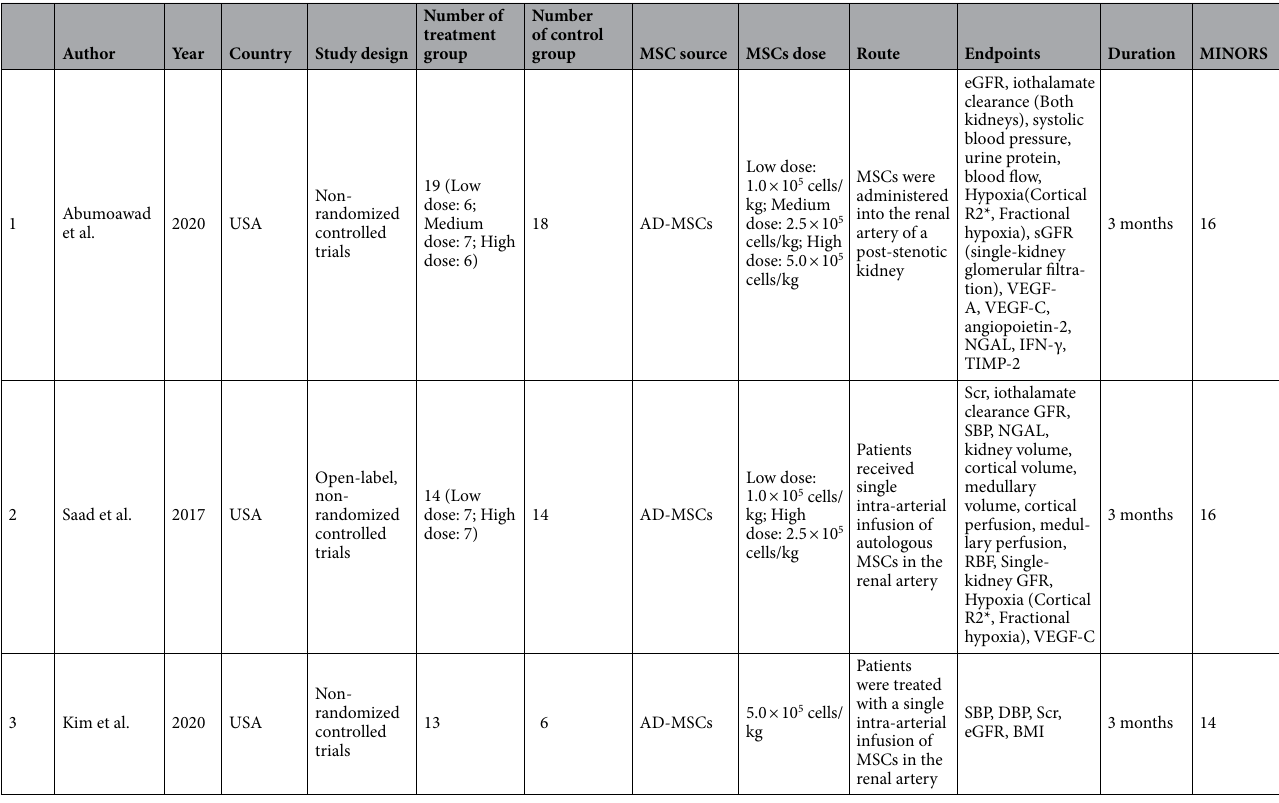
Table 2. Characteristics of clinical